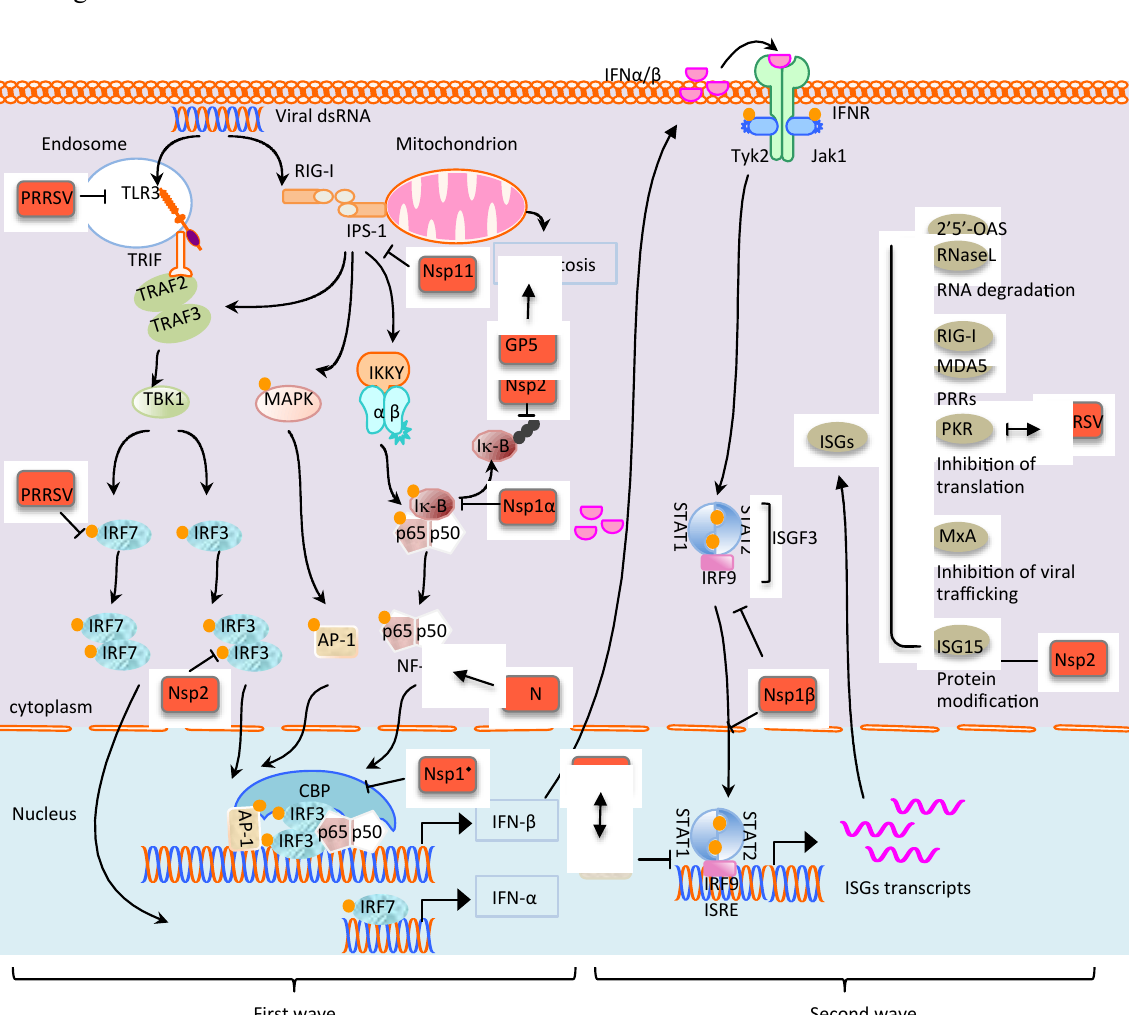
Figure 2. The modulation of type I IFN production by PRRSV. PRRSV has been shown to reduce the expression of TLR3 and IRF7 in pDCs. While Nsp1 has the ability to degrade CBP in the nucleus, Nsp1 α subunit inhibits the I κ B phosphorylation in the cytoplasm. Nsp2 inhibits IFN production by blocking the ubiquitinylation of phosphorylated I κ B and phosphorylation of IRF3 through the OTU domain. Nsp11 suppresses IFN- β production through degradation of IPS-1 mRNA. For the second wave of IFN signaling, PRRSV Nsp1 β blocks the phosphorylation of STATs and inhibits the nuclear translocation of ISGF3 complex. Nsp1 interacts with PIAS. Since PIAS is a multi-functional protein, Nsp1 interaction may also modulate pathways other than the JAK-STAT pathway. PKR is redistributed during PRRSV infection. Nsp2 has the potential to deconjugate ISGylation. The GP5 protein induces apoptosis. Since Nsp1 is cotranslationally processed to Nsp1 α and Nsp1 β in PRRSV-infected cells, the uncleaved form of Nsp1 is unlikely to exist in virus-infected cells. It is unknown which subunit of Nsp1 interacts with PIAS and degrades